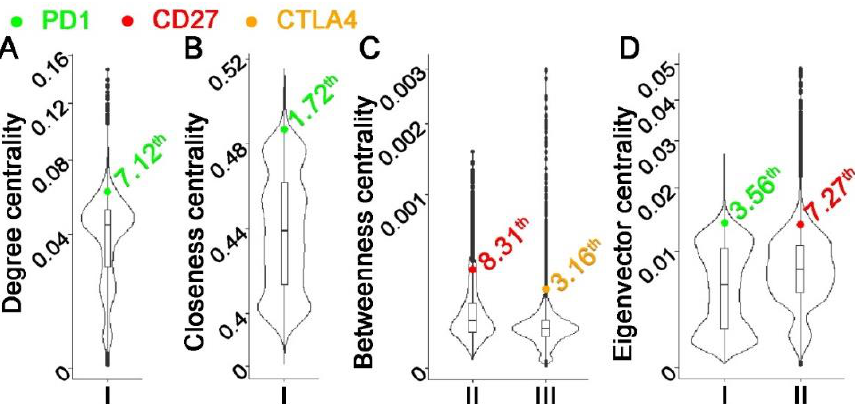
Figure 8. Distribution of centrality metrics in single-cell gene co-expression networks with CD27, CTLA4, or PD1 ranked within the top 10th percentile. Each subplot represented a centrality metric: ( A ). Degree centrality; ( B ). Closeness centrality; ( C ). Betweenness centrality; ( D ). VoteRank centrality. Each violin plot showed the distribution of the centrality metric in one specific network: I. T-cell PBL gene co-expression network in normal samples. II. T-cell PBL gene co-expression network in NSCLC patients. III. T-cell gene co-expression network in NSCLC tumors.